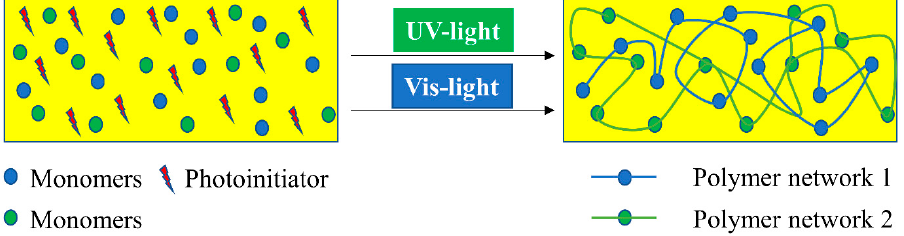
Figure 31. Conceptual illustration of orthogonally-evolved photopolymer networks via two different types of light illumination. Polymer Network 1 forms the first layer and polymer Network 2 forms the second layer for subsequent building of multi-material structures.